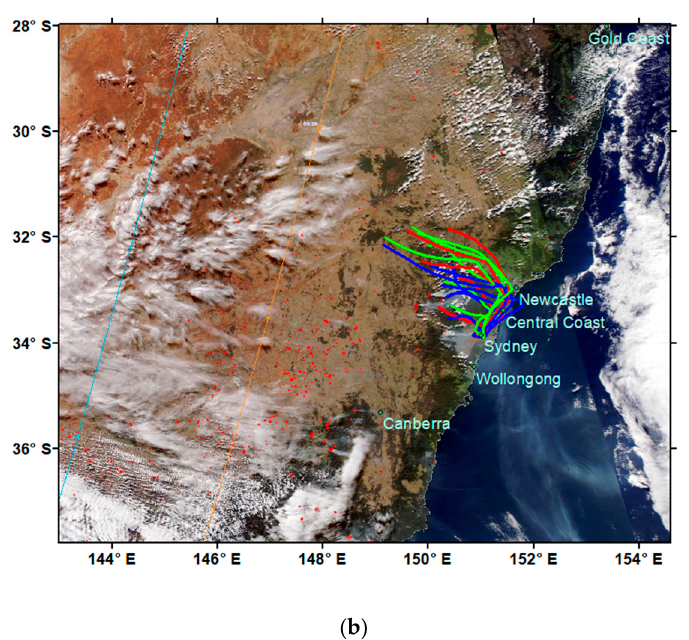
Figure 20. ( a ) Ensemble HYSPLIT backward trajectories from Chullora on 9 May 2019 00:00 AEST (8 May 2019 14:00 UTC). ( b ) Same as ( a ) but with MODIS and hot spots location. The backward trajectories showed the sources of high BC concentration came from the fires in the Blue Mountain (middle of ( b )). Fires in the Riverina (bottom left of ( b )) did not influence the BC concentration in Chullora and the GMR